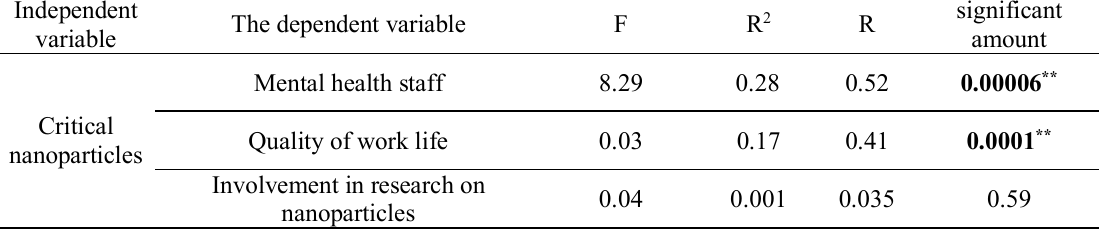
Table 1. Evaluation of the effects of nanoparticles on the variable critical petrochemical mental health personnel, quality of work life of employees and employee